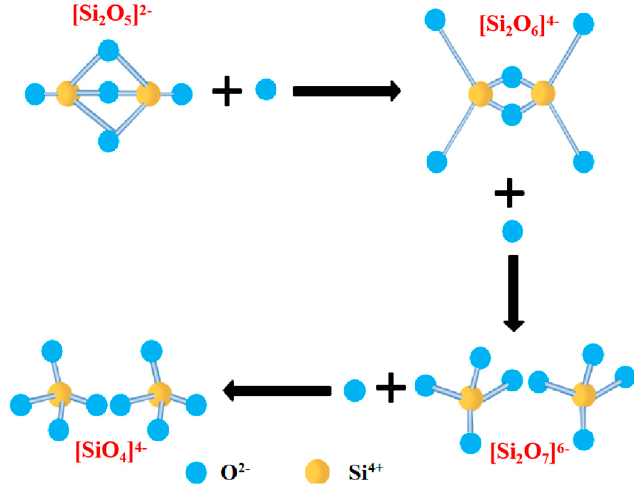
Figure 9. Silicon oxygen polymer microstructural evolution.